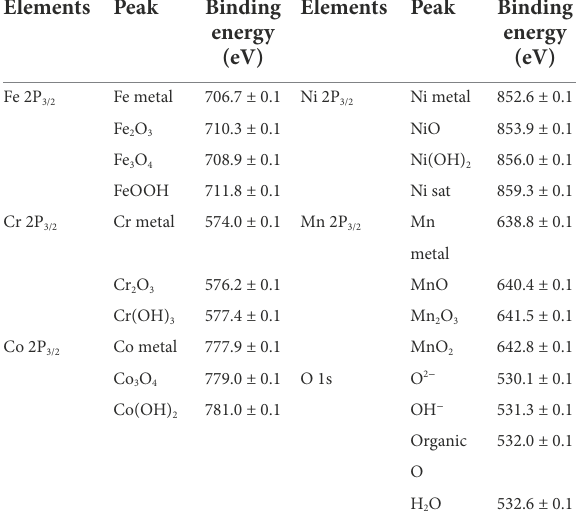
TABLE 1 Binding energies of the main components of FeCoNiCrMn